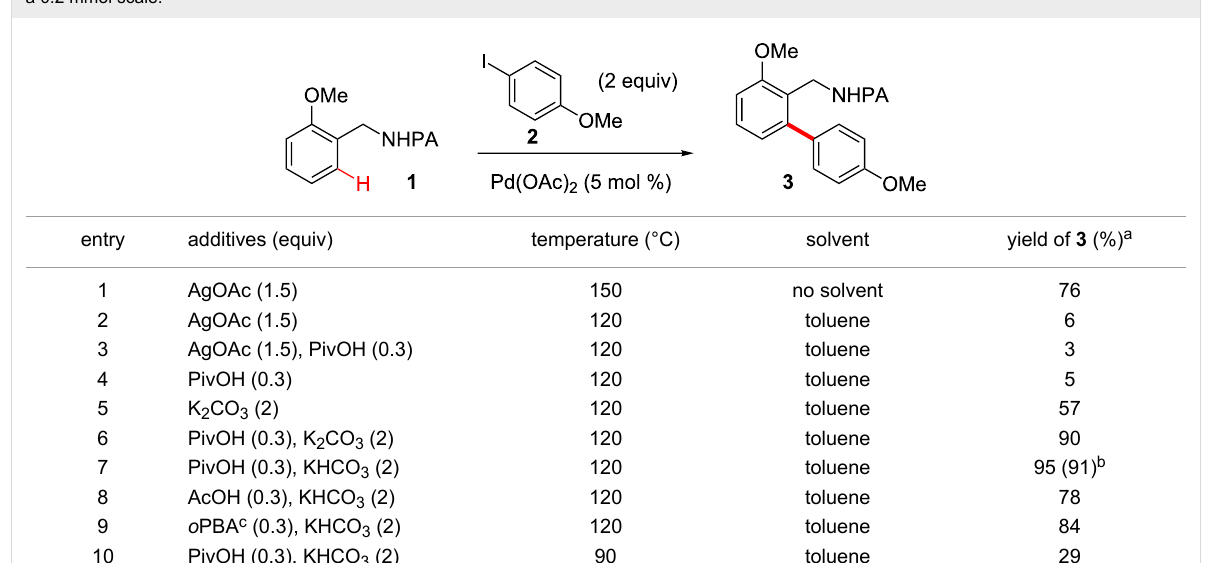
Table 1: Optimization of the Pd-catalyzed ortho -C–H arylation of benzylpicolinamide. All screening reactions were carried out in a 10 mL glass vial on a 0.2 mmol